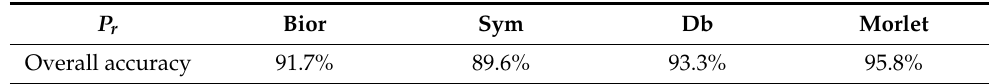
Table 4. PD recognition results in different wavelet functions.